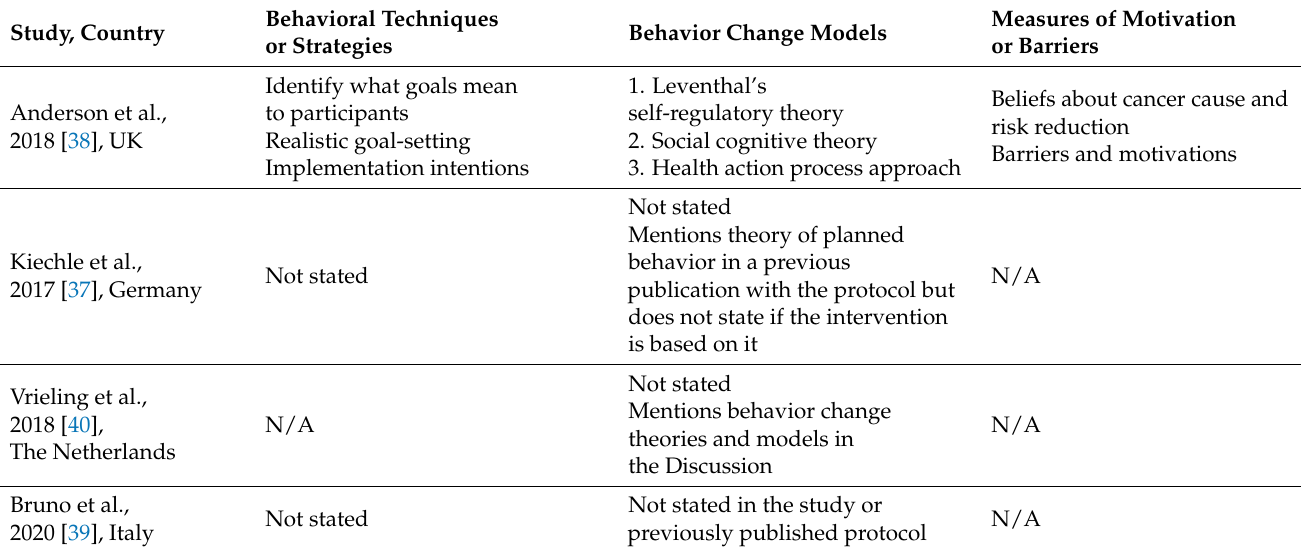
Table 3. Behavioral techniques and models used in each study.